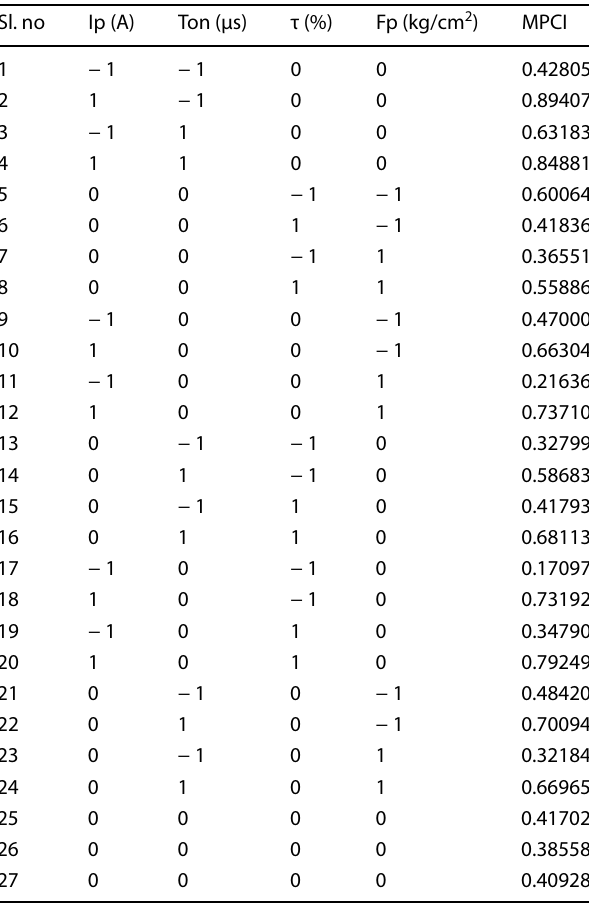
Table 6 Multi-response Performance Characteristic Index (MPCI)